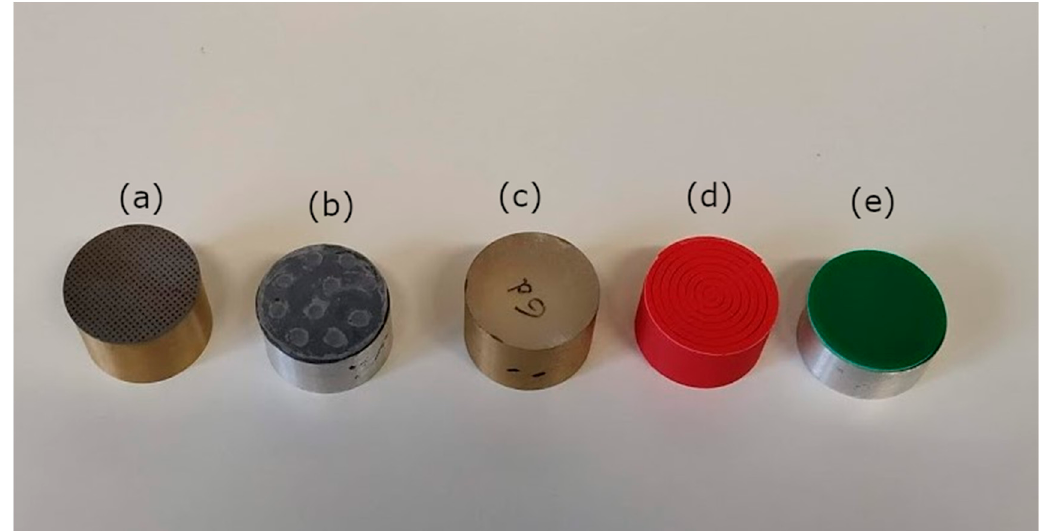
Figure 28. Several MPPs of diameter 28.5 mm, manufactured using distinct techniques. ( a ) Laser technology, ( b ) MIU, ( c ) infiltration technique, ( d ) 3D printing, and ( e ) drilling an epoxy laminate.